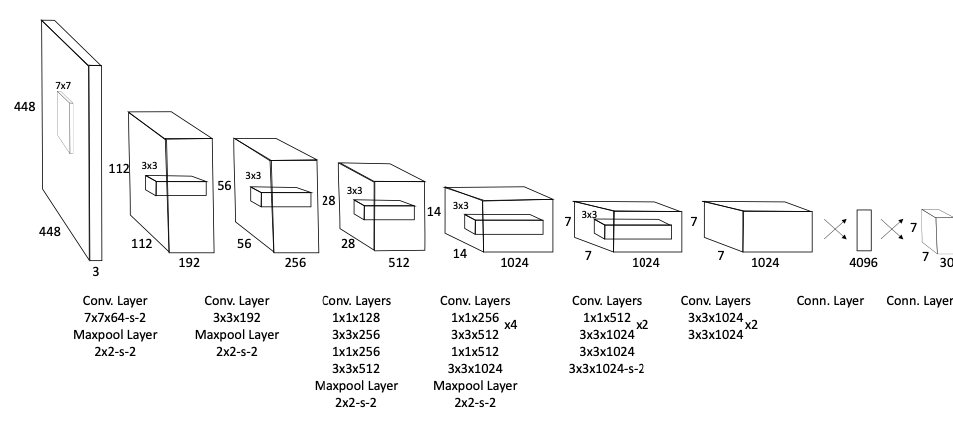
Figure 5. Architecture of